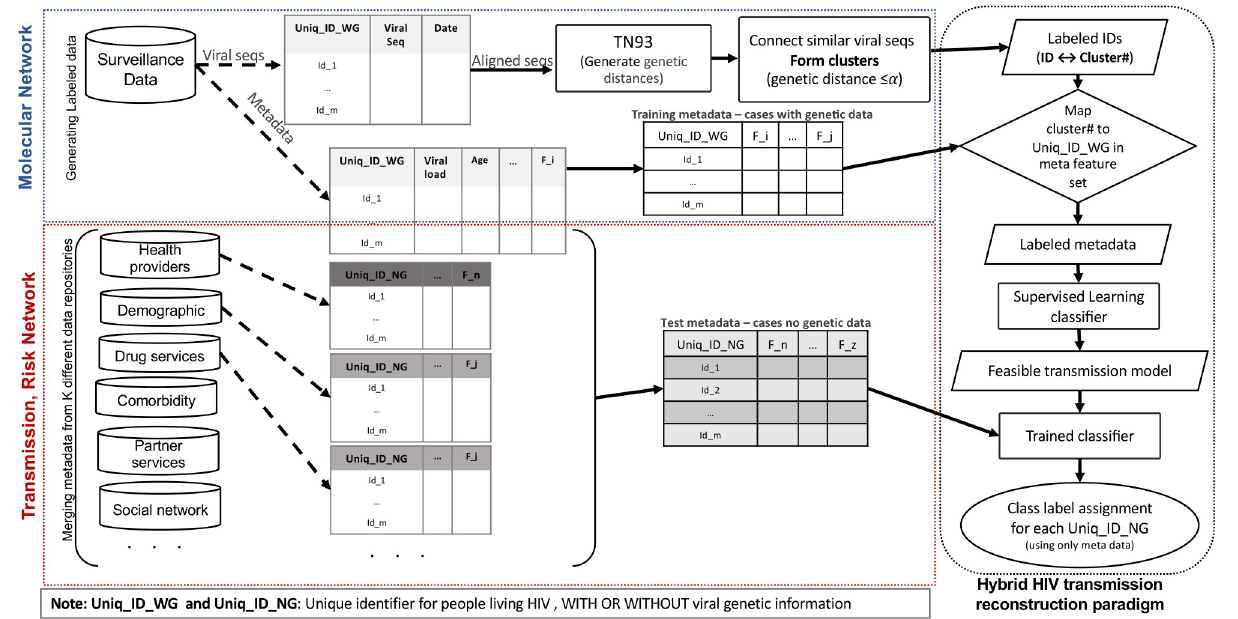
Fig 6. Hybrid unsupervised/supervised HIV transmission reconstruction model pipeline. Generating a labeled dataset from molecular data (blue dashed line box), reconstructing transmission network using labeled dataset (red dashed box), classification using augmented genetic and non genetic data (black dashed